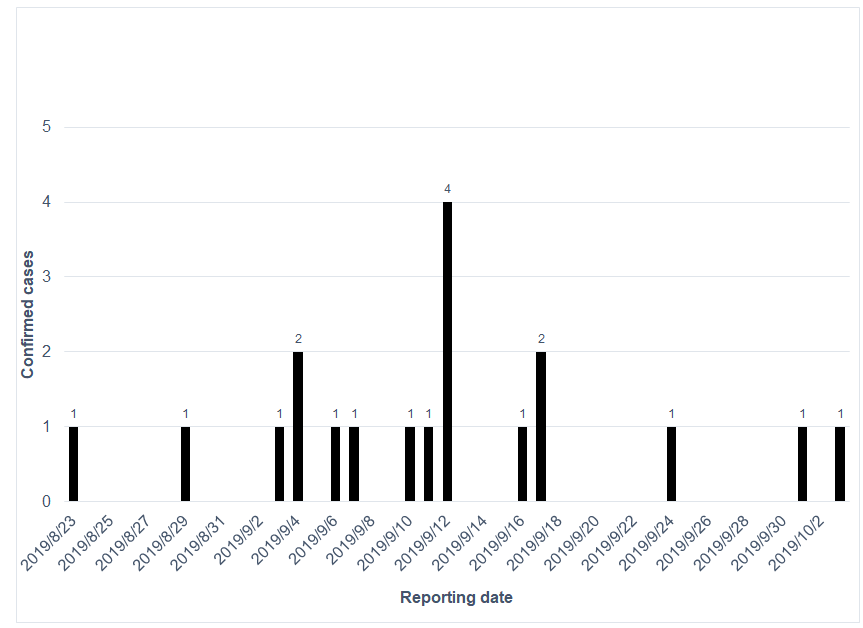
Figure 2. The epicurve of the confirmed chikungunya cases in order of reported